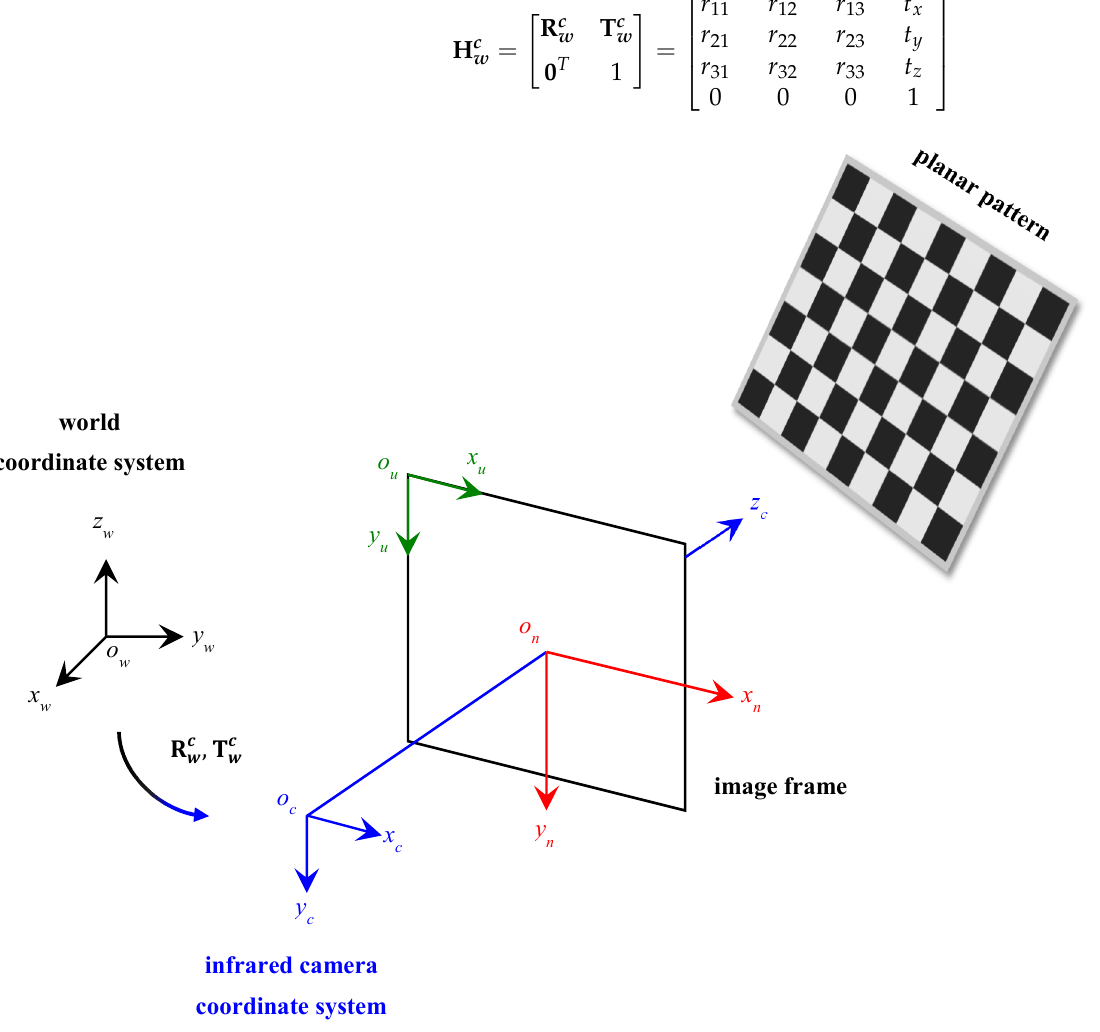
Figure 2. A schematic representation of the camera calibration setup following Zhang’s model [58] by mapping the 3D world scene into an image plane using a randomly oriented planar checkerboard target.